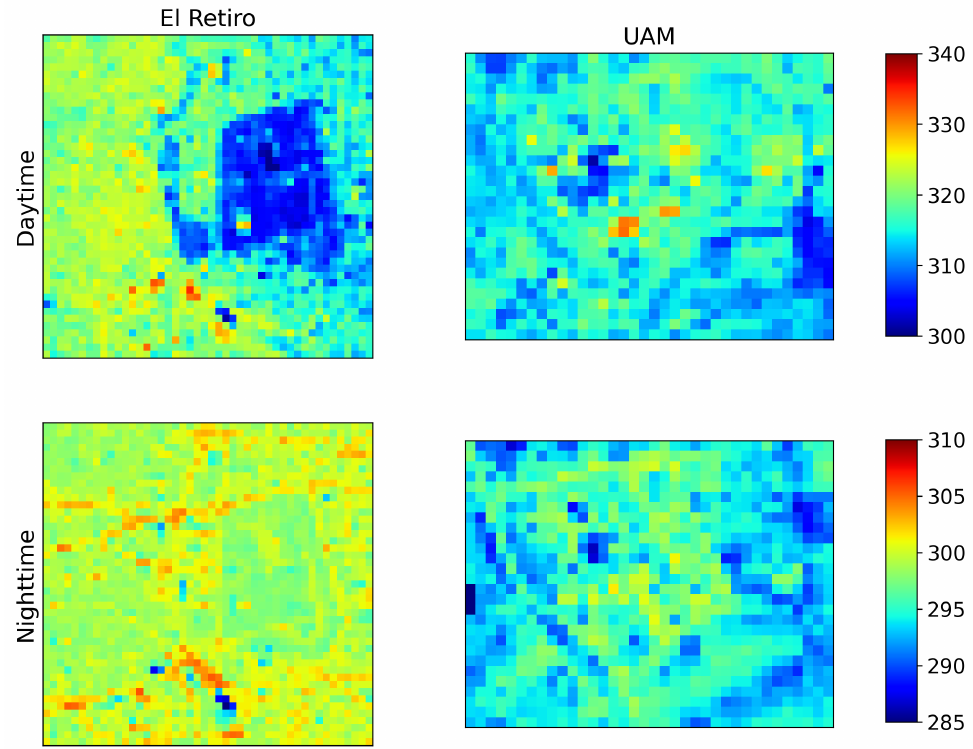
Figure 14. The 60-m aggregated LST from the 2MMD-4-band TES over the Retiro park ( left ) and the UAM ( right ) during the daytime ( top ) and nighttime ( bottom